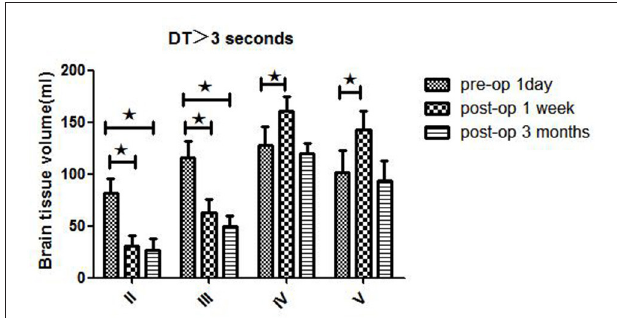
TABLE 1 | Baseline characteristics of 126 ischemic MMD patients.